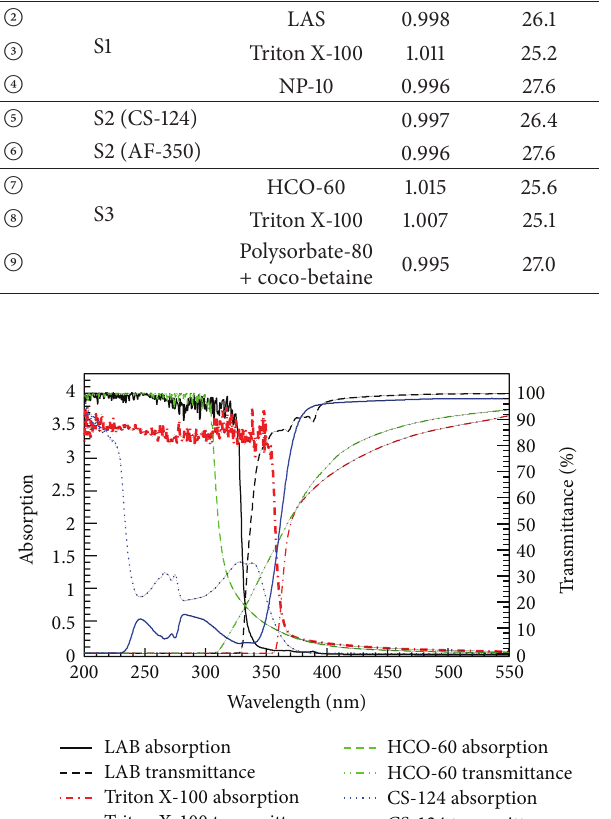
Figure 6: Transmittance [ 𝑇 ] and absorption [ 𝐴 ] values of S1 (Triton X-100), S2 (CS-124), and S3 (HCO-60) samples as functions of wavelength on one plot. The solid line represents the absorption, and the dashed line represents the transmittance. 𝑇 is related to 𝐴 = − log 𝑇 . The transmittance of various samples is given as a percentage.